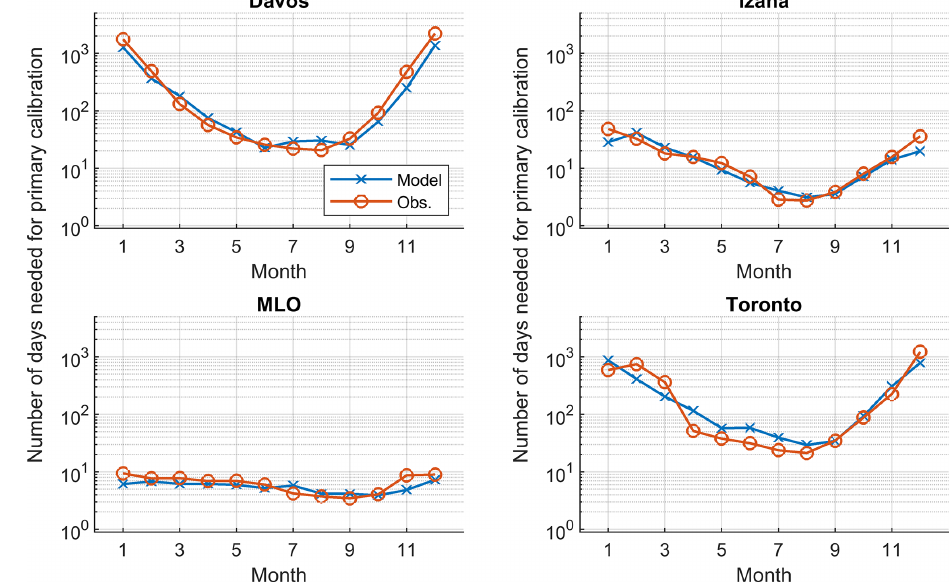
Figure 7. The number of days needed for primary calibration work at different sites in different months. Blue lines are the results from the ETC simulation model based on MERRA-2 reanalysis, and red lines are the results using real Brewer observations. Both blue and red lines use the same observation records from the Cimel sun photometer and Brewer DS ozone to infer aerosol and weather